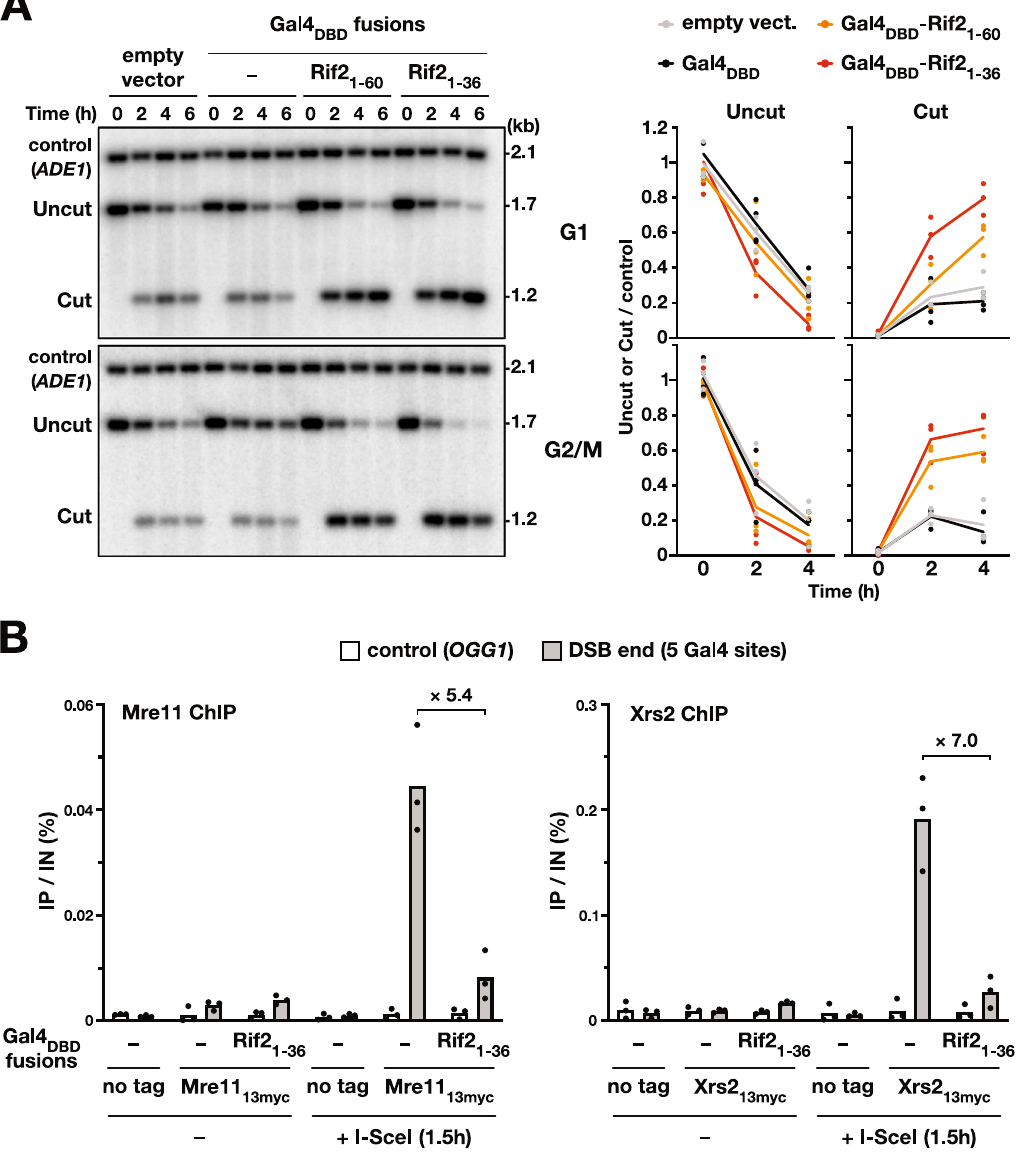
Fig. 3 Rif2 BAT blocks 5 ′ resection and MRX complex presence at broken ends. A Rif2 N-terminal region stabilises broken ends. Left panel: the stability of I-SceI-induced broken ends with 5 Gal4 sites determined by Southern blot in G1 and G2/M arrested cells. Right panel: quanti fi cation of the uncut and cut signals normalised to the control ADE1 signal. Means from independent samples. Experiment reproduced three times. B Mre11 and Xrs2 presence at I-SceI- induced broken ends with 5 Gal4 sites determined by ChIP in G1 arrested cells. Quanti fi cation of immunoprecipitated DNA (IP) relative to the input DNA (IN). Means from independent samples. Quanti fi cation of I-SceI cleavage ef fi ciency in Supplementary Fig.